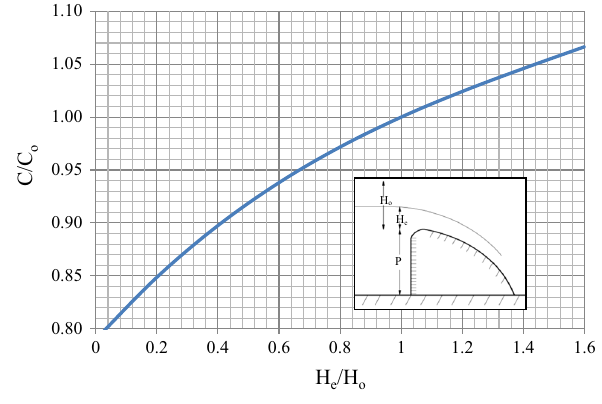
Fig. 3 Discharge coefficient for various total head (USBR 1987)